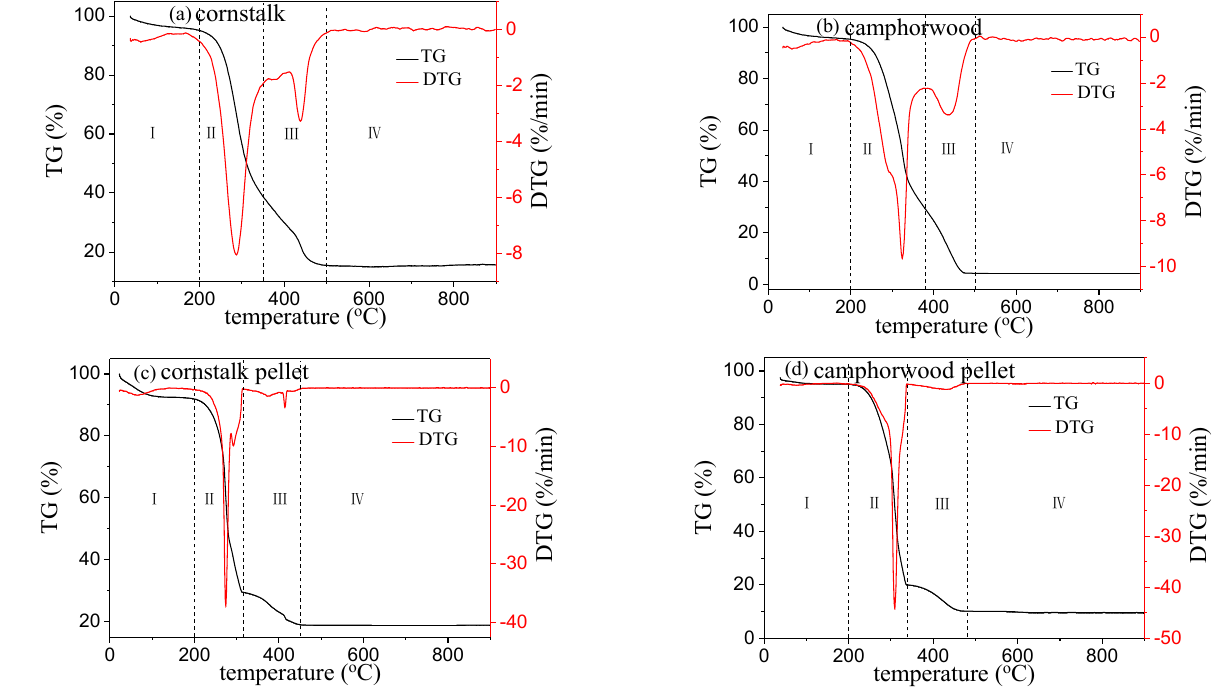
Figure 2. TG − DTG curves of biomass and biomass pellets. ( a ) cornstalk; ( b ) camphorwood; ( c ) cornstalk pellet; ( d ) camphorwood pellet.